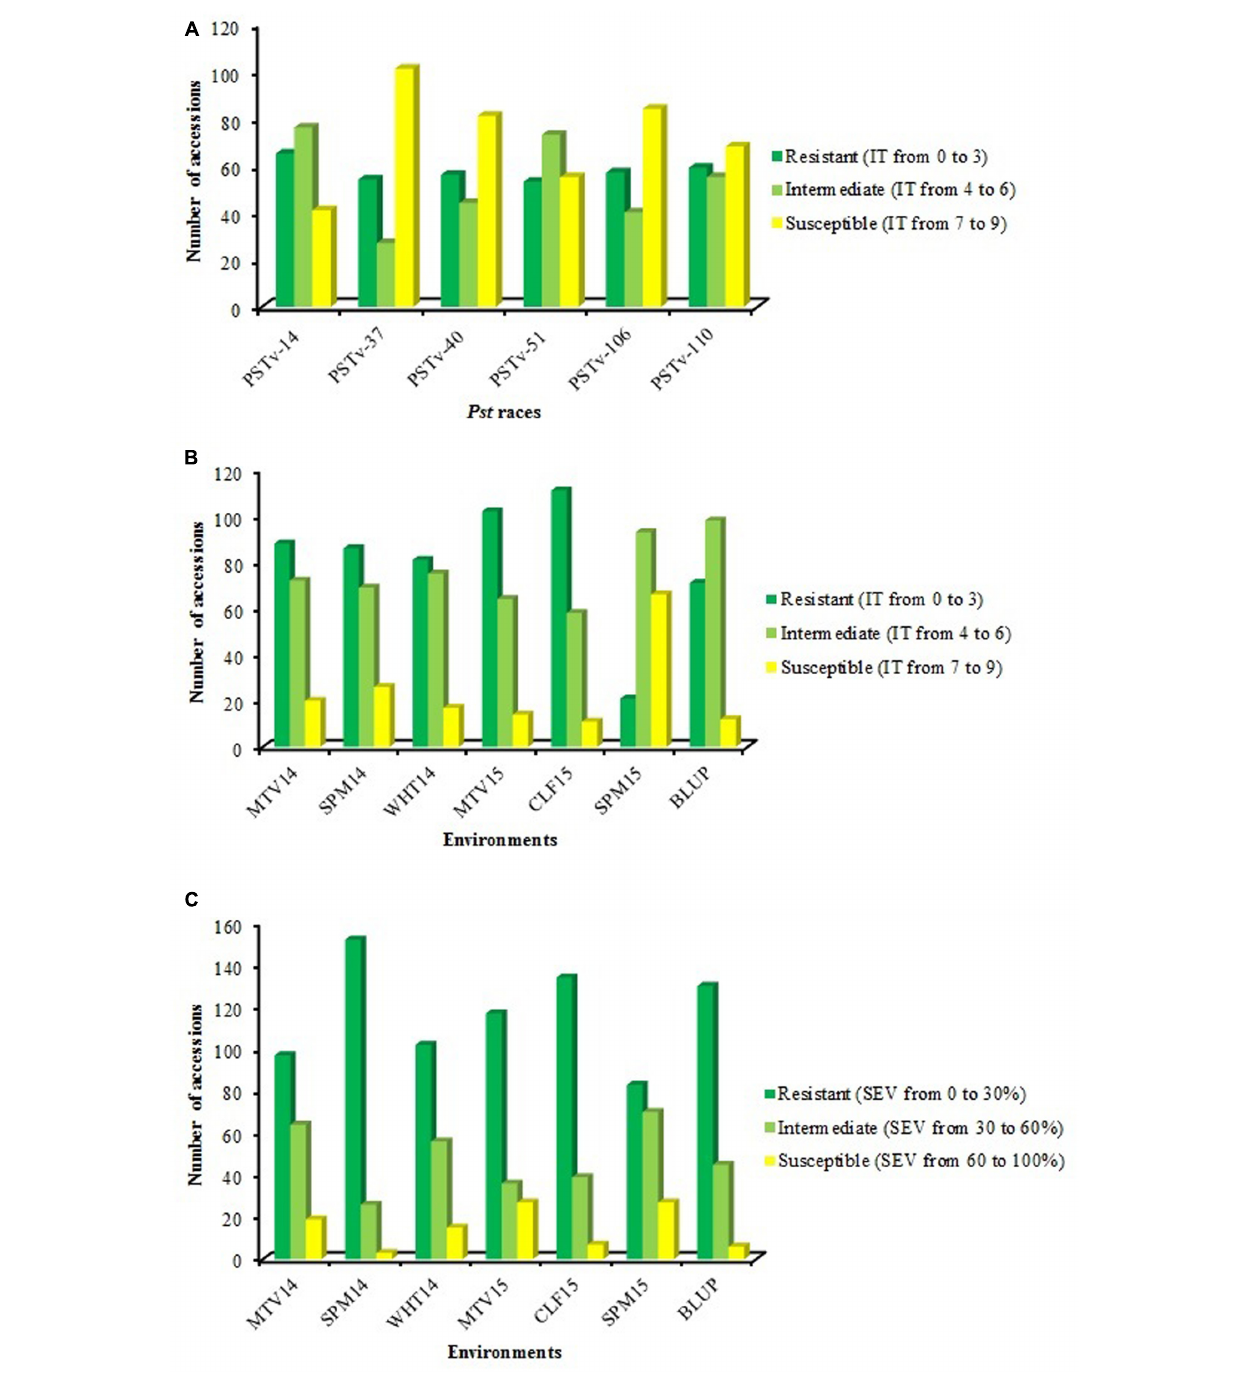
FIGURE 1 | Reaction distributions of 182 Ethiopian durum wheat landraces to Puccinia striiformis f. sp. tritici : (A) infection type (IT) to PSTv-14, PSTv-37, PSTv-40, PSTv-51, PSTv-106, and PSTv-110, (B) IT and (C) disease severity (SEV) in individual environments as well as best linear unbiased predictor (BLUP) across all environments at the adult